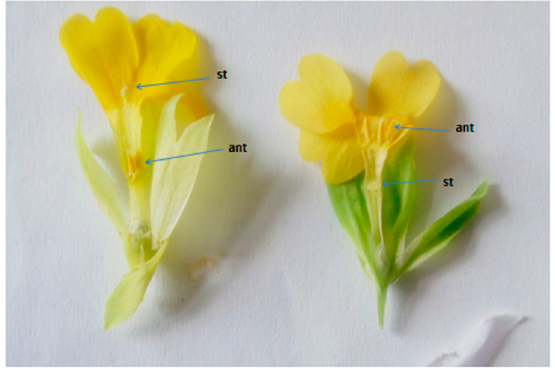
Figure 1. Distyly in P. veris : “pin” floral morph (to the left) and “thrum” flower morph (to the right), st — style; ant—anthers.